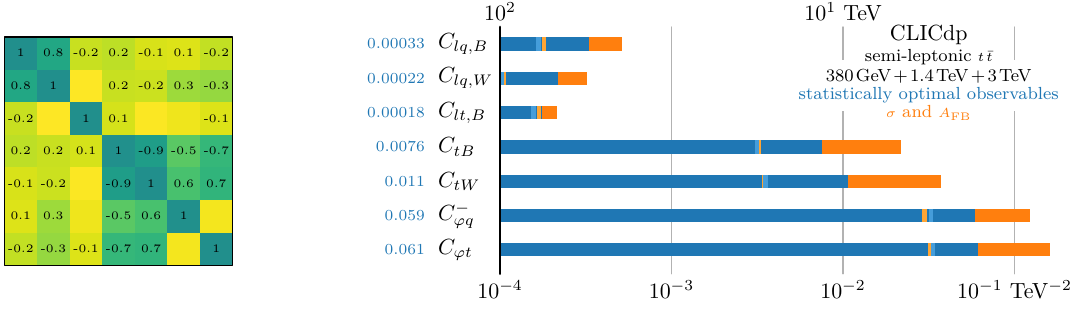
Figure 34. Same as (cid:12)gure 33, but including operation at 3 TeV CLIC using 5 : 0 ab (cid:0) 1 , split in the ratio 80:20 for operation with -80% and +80% electron beam polarisation,